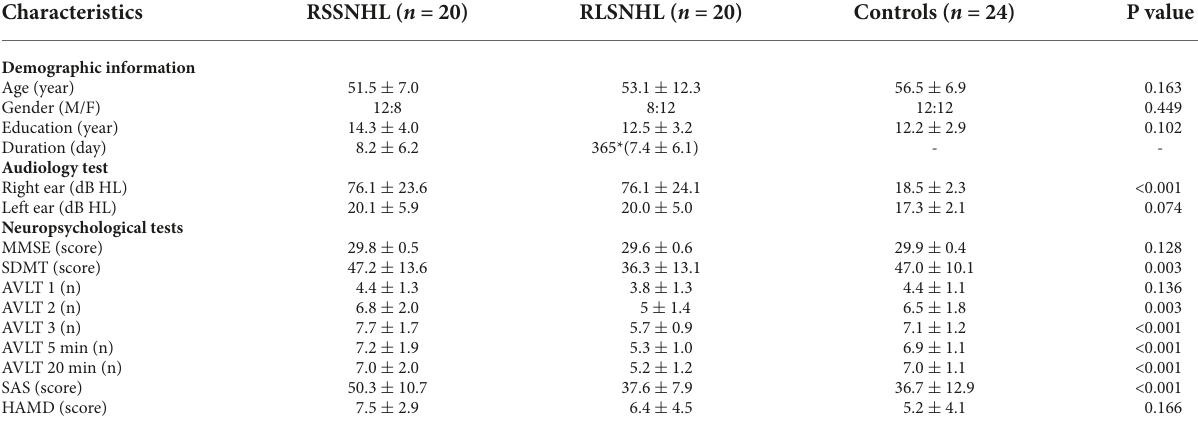
TABLE 1 Demographic information, auditory ability, and neuropsychological features of RSSNHL, RLSNHL, and Controls. Characteristics